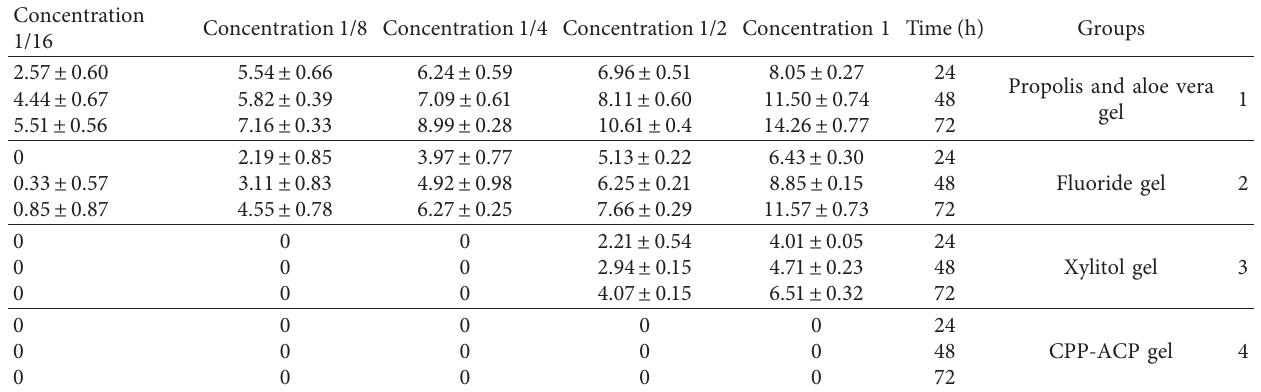
Table 2: Mean diameter ± standard deviation of Lactobacillus growth inhibition zone in different concentrations of each gel.